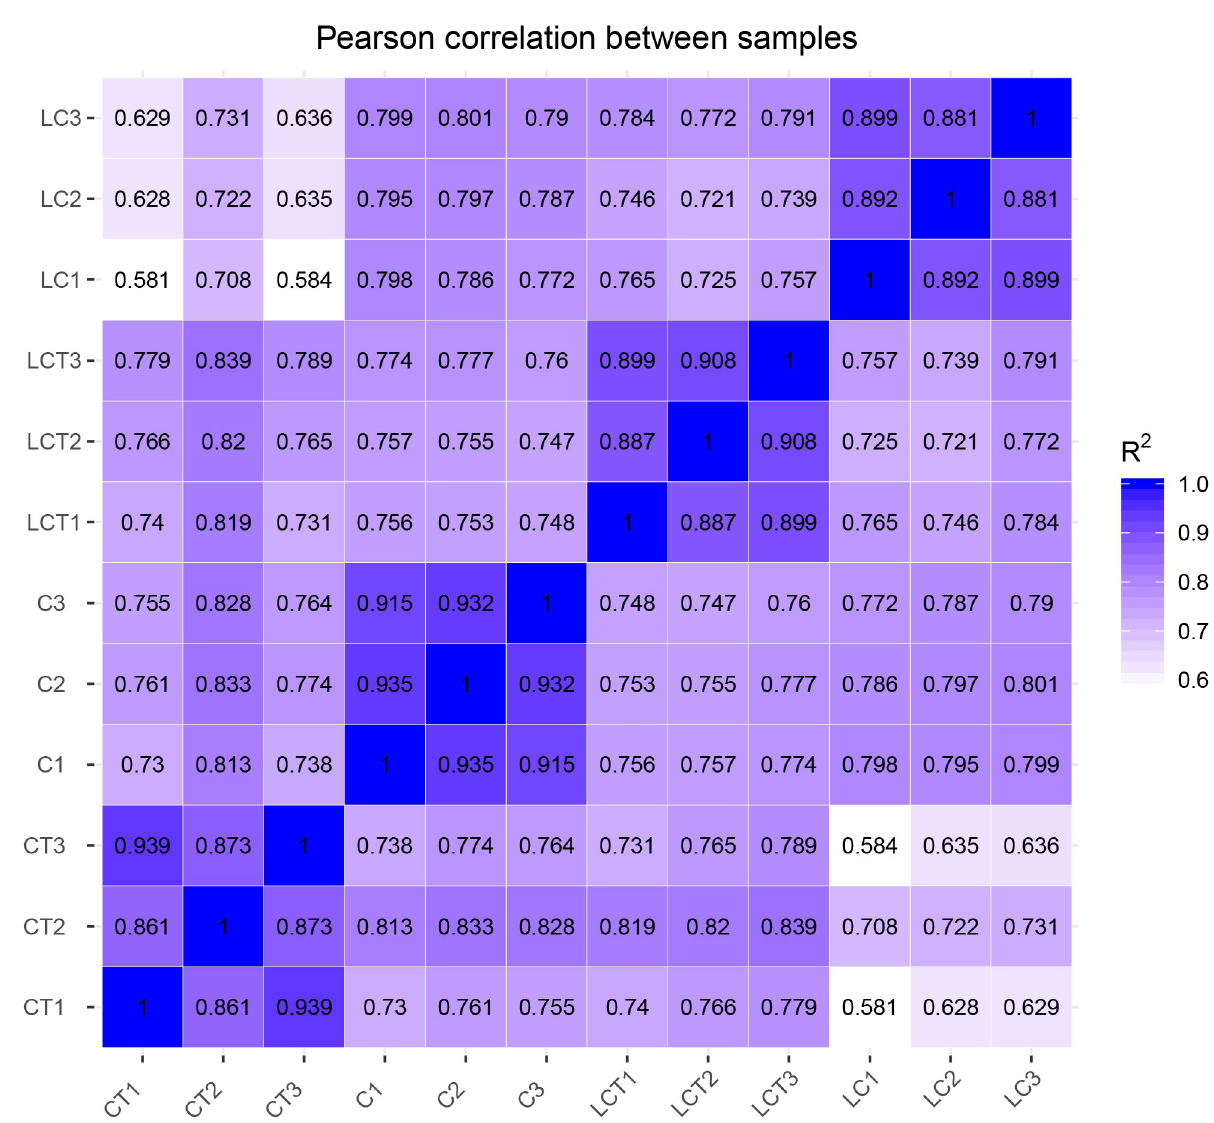
Fig 3. Correlation heat map between